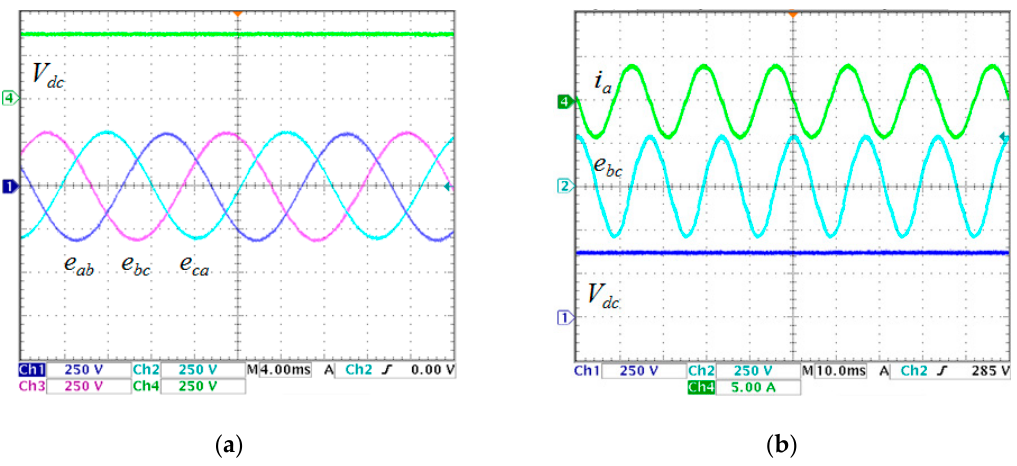
Figure 14. Experimental waveforms of the proposed inverter: ( a ) e ab , e bc , e ca and V dc ; ( b ) i a , e bc , and V dc .